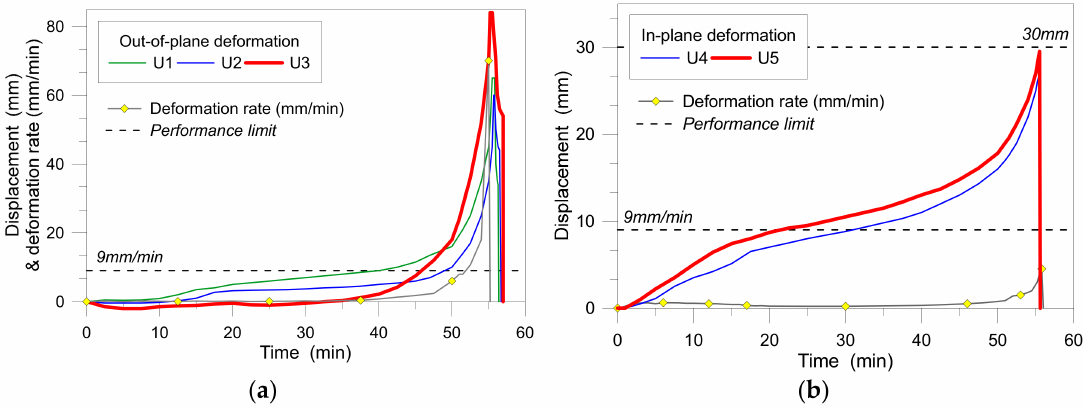
Figure 6. Experimental history of ( a ) out-of-plane and ( b ) in-plane deformations/deformation rates for the W80 specimen, with evidence of the reference performance limits (EN